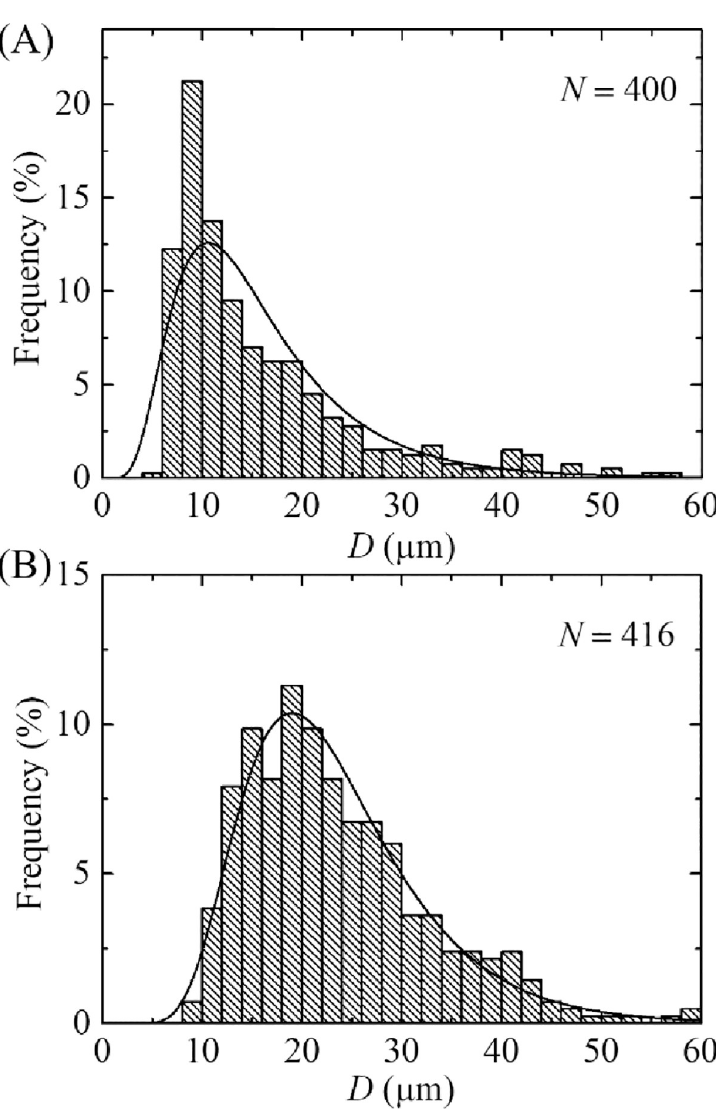
Fig 7. Effects of single filtration on the size distribution of 40%DOPG/60%DOPC-GUVs. The size distribution histogram of the (A) unpurified and (B) purified GUV suspension using a 12 μ m pores polycarbonate membrane. The purification was performed at flow rate 1 mL/min for 1 h. The solid line of figures corresponds to fitting with Eq 1.